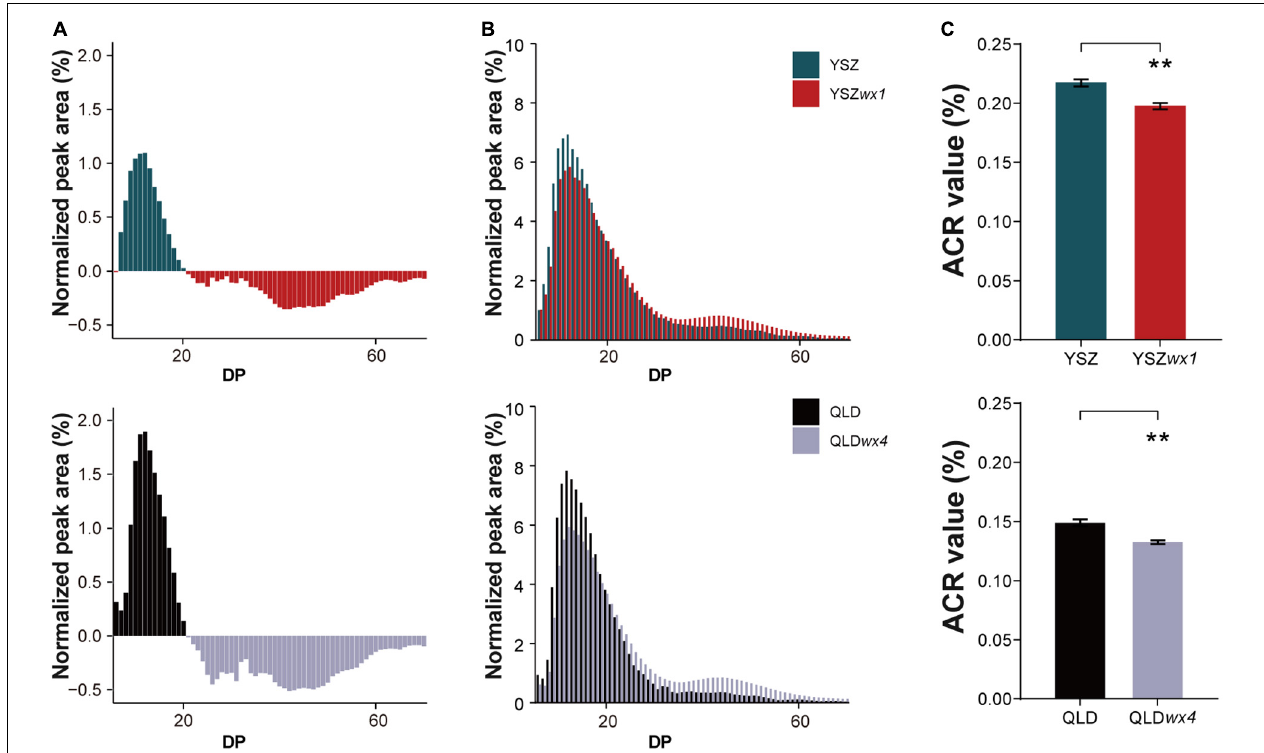
FIGURE 4 | The fine structure of amylopectin in wx mutants and their corresponding WTs. (A) Comparison of percentage values of high-performance anion-exchange chromatography with pulsed amperometric detection (HPAEC-PAD) chromatograms of amylopectin chain length between wx mutants and their corresponding WTs. The plus values represent the WTs and the minus values represent the wx mutants. (B) The difference in the chain-length distribution of amylopectin between wx mutants and their corresponding WTs. (C) The (cid:54) DP ≤ 10/ (cid:54) DP ≤ 24 values of wx mutants and their corresponding WTs. ACR: amylopectin chain ratio. Error bars are mean ± SD ( n = 3). Significant differences were determined by Student’s t -test: ** P <